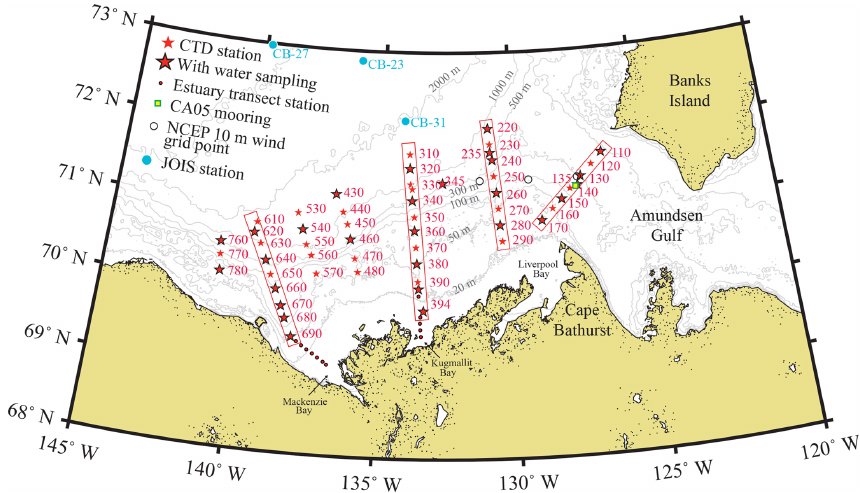
Figure 1. Map of study area with stations sampled along transect lines 100 to 700 during the MALINA expedition in 2009. Stars indicate stations visited by CCGS Amundsen , and small circles indicate the estuarine stations sampled by the barge. CTD rosette water sampling was conducted at the 28 stations marked by stars with black borders. Black circles are the three locations selected for NCEP 10m winds. The green-yellow square near station 140 indicates the location of the long-term mooring CA05 with a current meter at 178m. The cyan circles mark the locations for three of the profiles shown in Fig. 9. The fourth station, CB-21, was located 1 ◦ north of